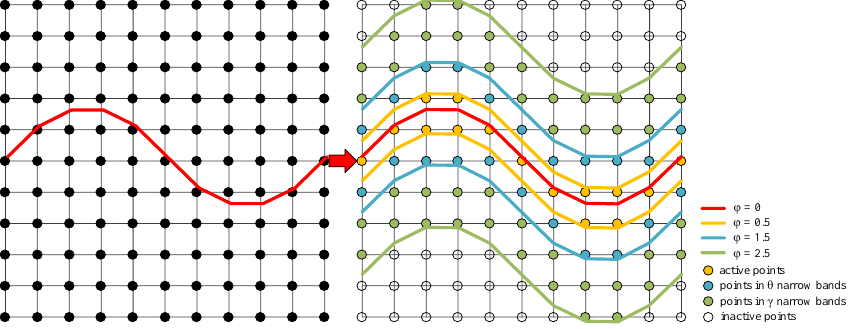
Figure 5. Illustrations of 2-D simulation domain for all spacing grids and the three-layer narrow band.